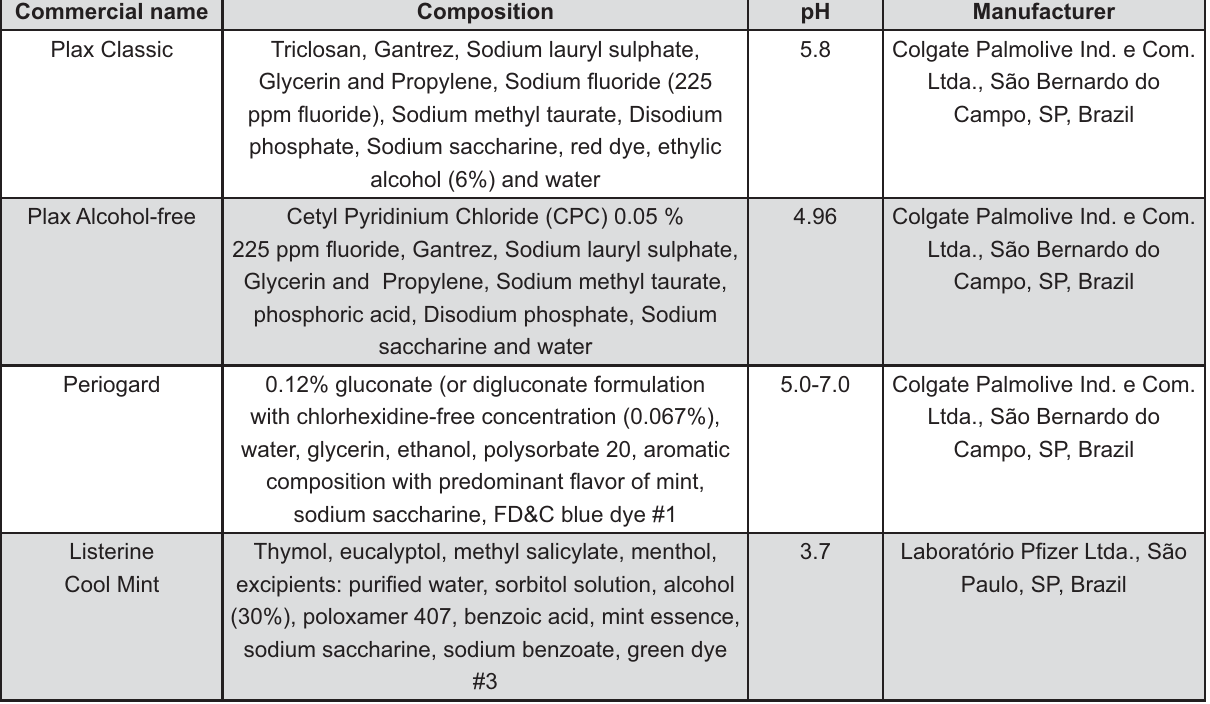
Figure 2- Tested mouth rinses Table 1-